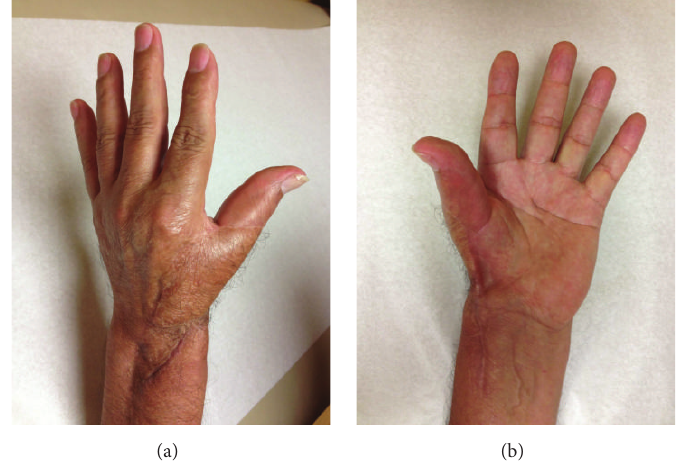
Figure 4: Postoperative clinical photographs. (a) Dorsal view. (b) Palmar view.